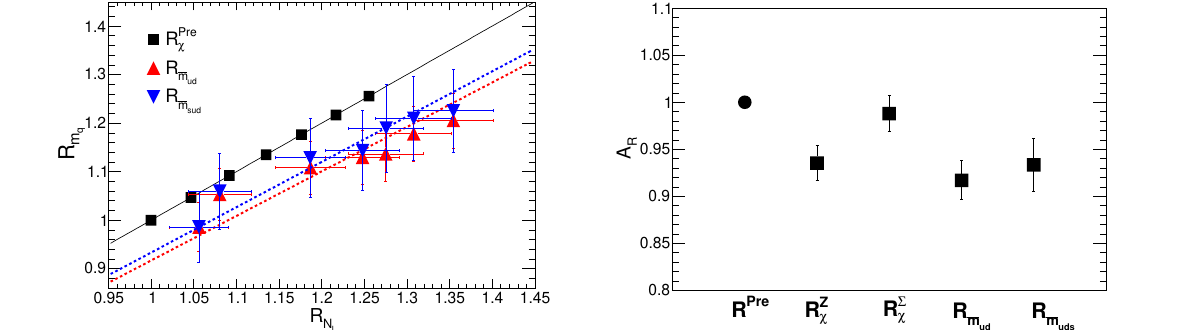
with the pre- Figure 22 . Comparisons of the (cid:12)tting results q of slope A R with the prediction A Pre